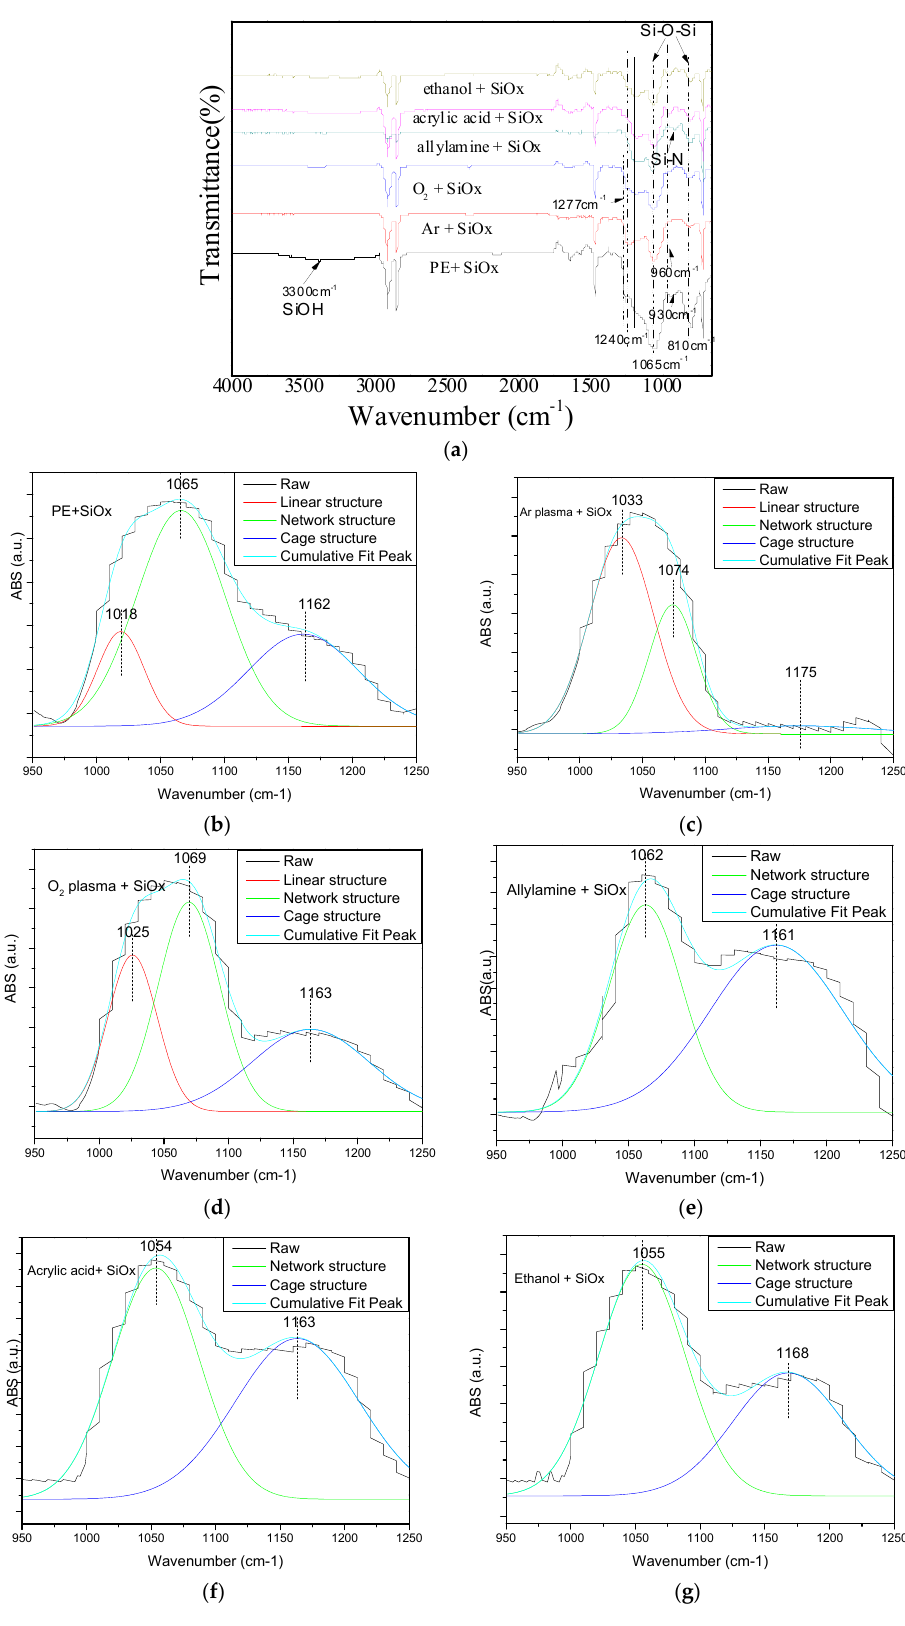
Figure 6. ATR-FTIR spectroscopy of SiOx coating with different DBD pre-treatment PE sheets as substrates ( a : the survey of SiOx coatings deposited on different pre-treated PEs. The deconvolution of Si–O in the range of 950 cm − 1 –1250 cm − 1 in b - PE + SiOx, c -Ar plasma + SiOx, d - O 2 plasma + SiOx, e - Ar + llylamine + SiOx, f - Ar + acrylic acid + SiOx, and g -Ar + ethanol + SiOx.). Table 1. The ratio of deconvoluted Si–O–Si in three peaks at 1023 cm − 1 , 1063 cm − 1 and 1135cm − 1 for linear, network and cage micro-structures, respectively.